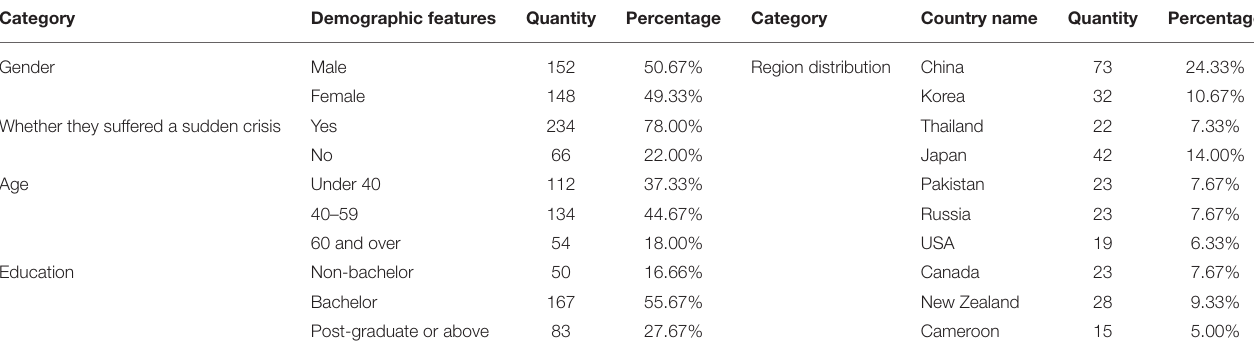
TABLE 2 | Statistical of demographic